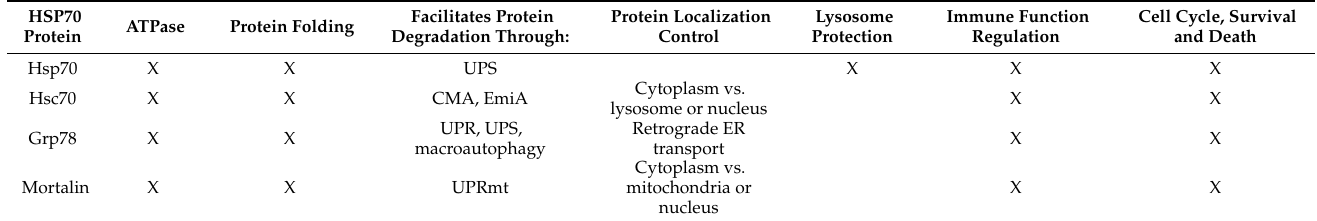
Table 1. Comparison of HSP70 protein functions.